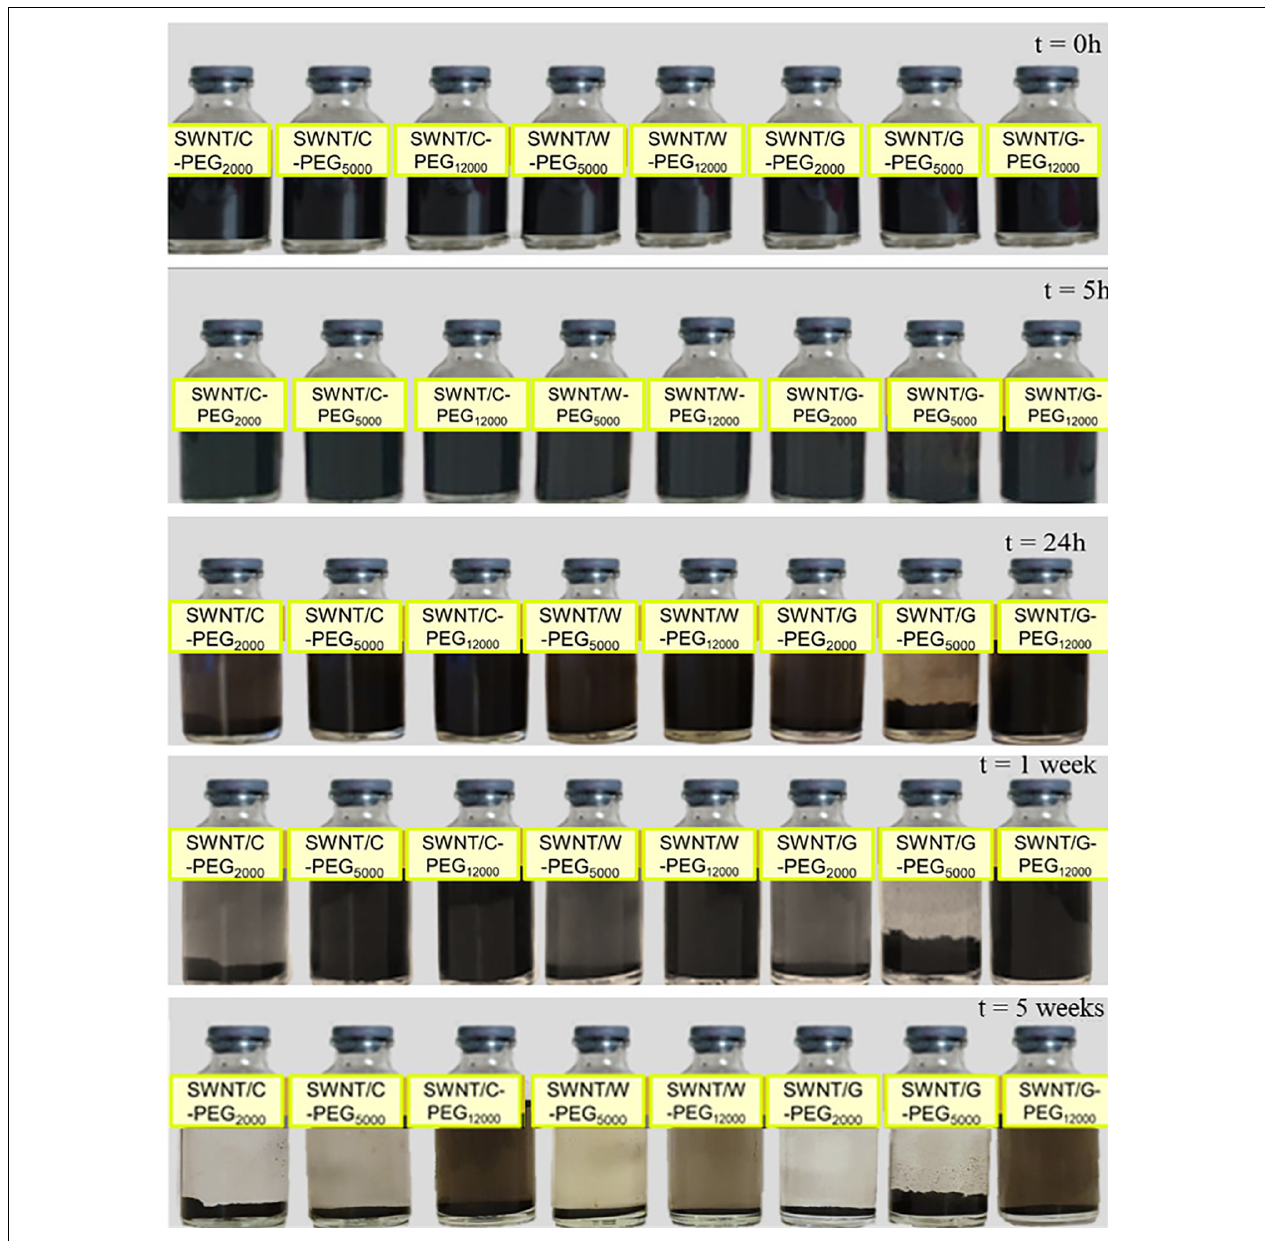
FIGURE 10 | Distribution of SWNT/G-PEG 2000 , SWNT/G-PEG 5000 , SWNT/G-PEG 12000 , SWNT/W-PEG 5000 , SWNT/W-PEG 12000 , SWNT/C-PEG 2000 , SWNT/C-PEG 5000 , and SWNT/C-PEG 12000 in water.